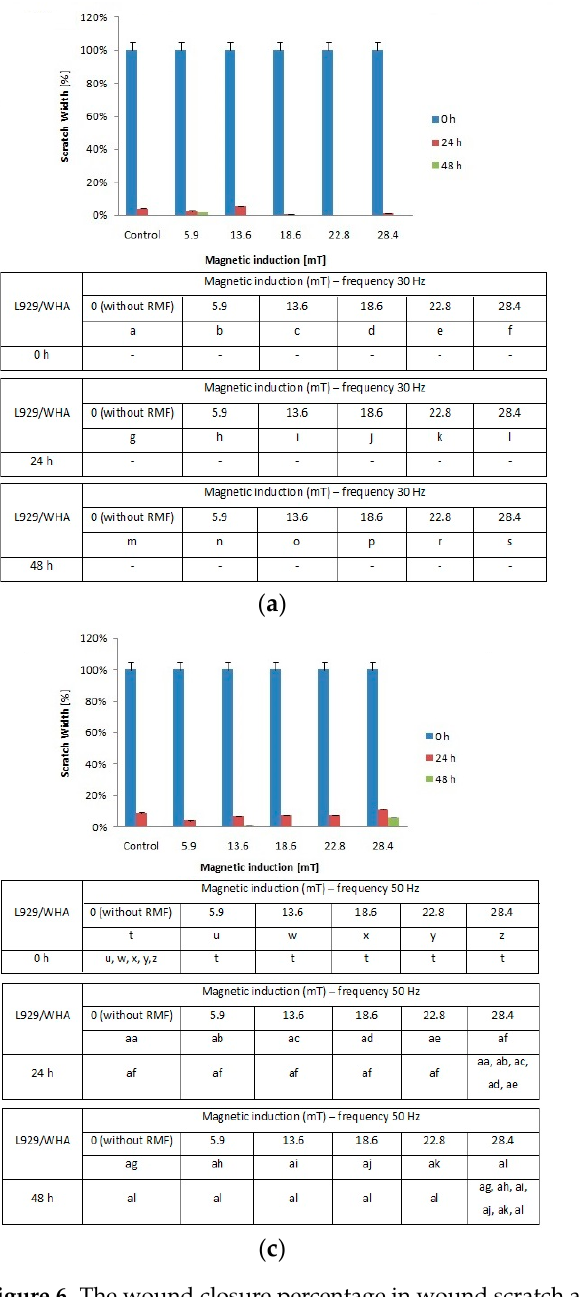
Figure 6. The wound closure percentage in wound scratch assay after 24 and 48 hours from 4-hour exposition to RMF (measured by ImageJ software). ( a ) L929 cells—frequency 30Hz; ( b ) HaCaT cells—frequency 30 Hz; ( c ) L929 cells—frequency 50 Hz; ( d ) HaCaT cells—frequency 50 Hz (all samples were compared to control; p -values ˂ 0.05 were considered significant and were represented by small letters).